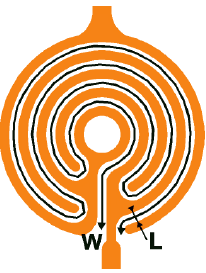
Figure 2. Structure of the comb-shaped sensing electrodes.